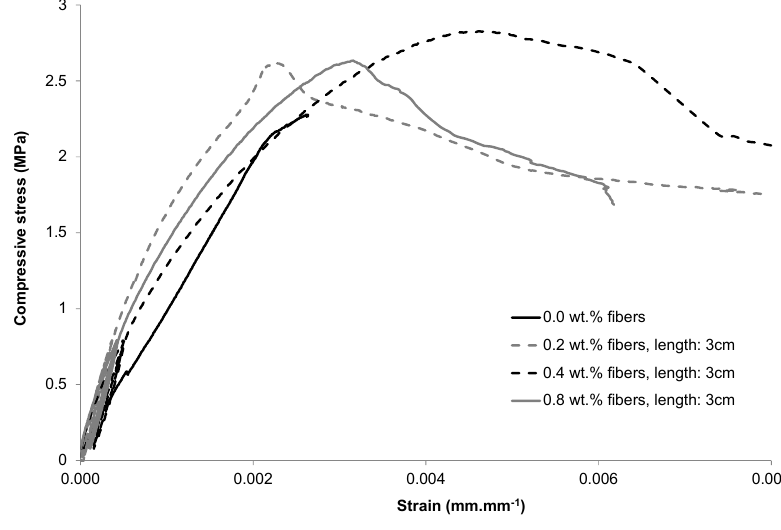
Figure 7. Compressive stress-strain behavior of fiber-reinforced PABs.